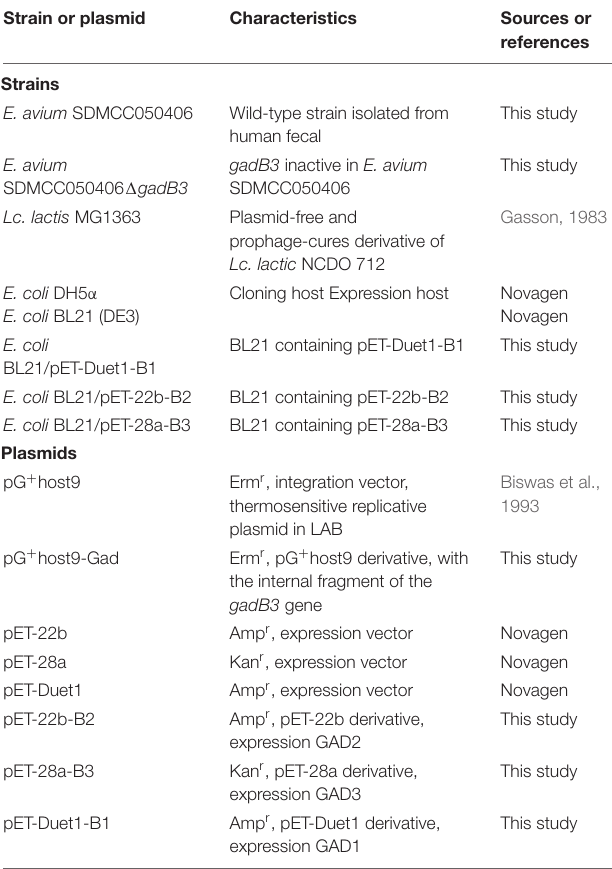
TABLE 1 | Bacterial strains and plasmids used in this study.